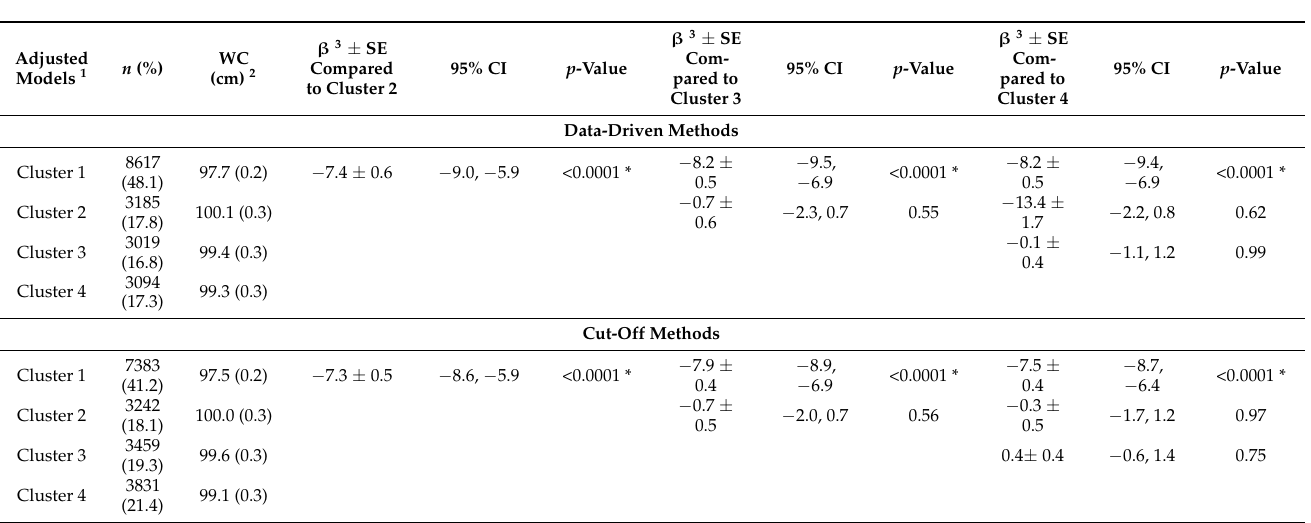
Table 4. Adjusted regression model results for mean WC (cm) with clusters representing TDPs of U.S. adults 20–65 years as drawn from the NHANES, 2007–2016, generated based on data-driven methods and cut-off